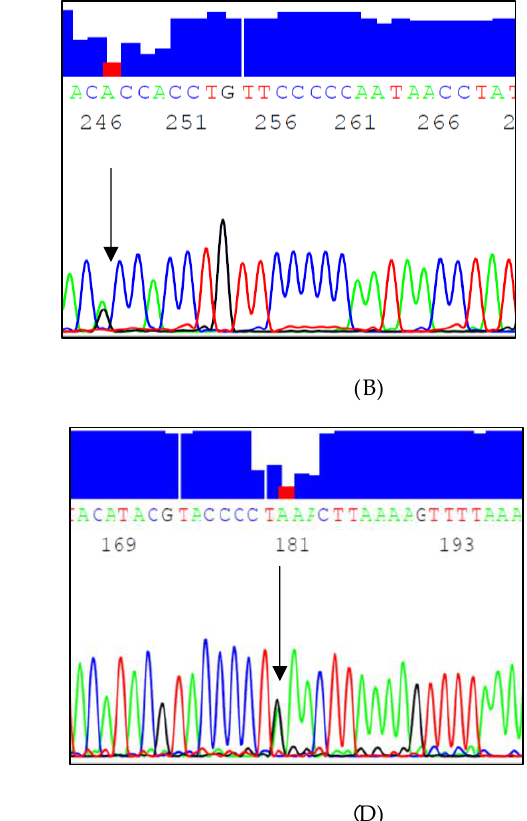
Figure 1. Sequencing electropherograms of the target regions (8:19956194-19956691 and 8:19958317- 19958887) in intron 6 at the lipoprotein lipase ( LPL ) gene locus showing the InDels identified. ( A ) (rs293 ) c.1019-685_1019-684insA (forward strand); ( B ) (rs274 ) c.1018+386_1018+387insA (reverse strand); ( C ) (rs274 ) c.1018+386_1018+387insA (reverse strand). The vertical bars represent the Qual- ity values (QV) designated to each base of the sequencing reaction analyzed by the software. The blue bars represent values of ≥20 (very good data), while the yellow and red bars represent values <20 (poor data).